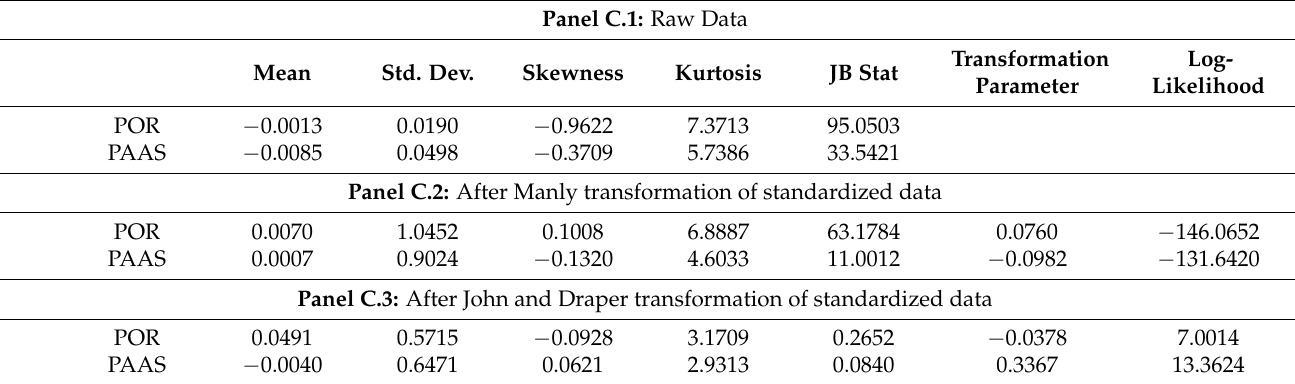
Panel C.1: Raw Data